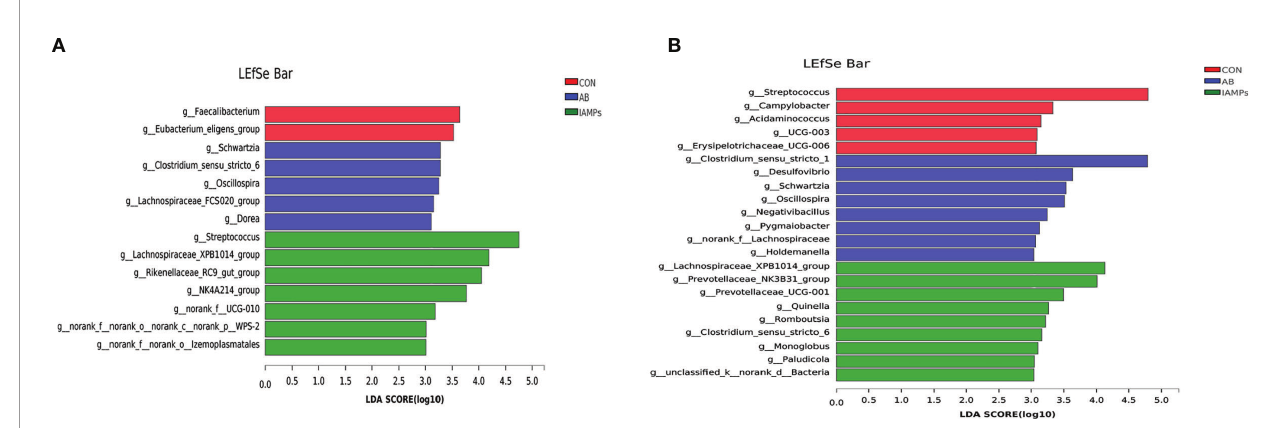
FIGURE 7 | Identi fi cation of the most differentially abundant genera in the digesta samples of weaning piglets by linear discriminant analysis effect size (LEfSe) analysis. (A) cecum; (B) colon. The individual pig was regarded as the experimental unit (n = 5). CON, corn – soybean meal-based diet; AB, CON + 25